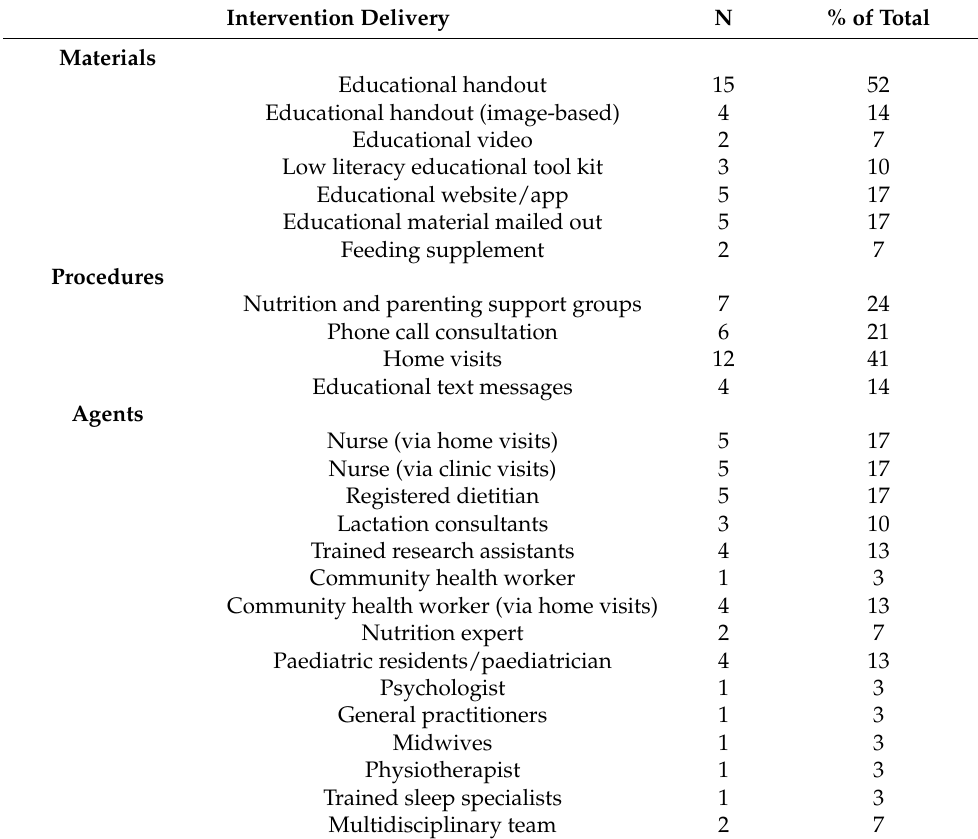
Table 2. Intervention delivery materials, procedures, and agents used in early intervention studies for the prevention of obesity in infancy (N = 29). (Refer to Tables S2 and S3 for more detail on individual trials)